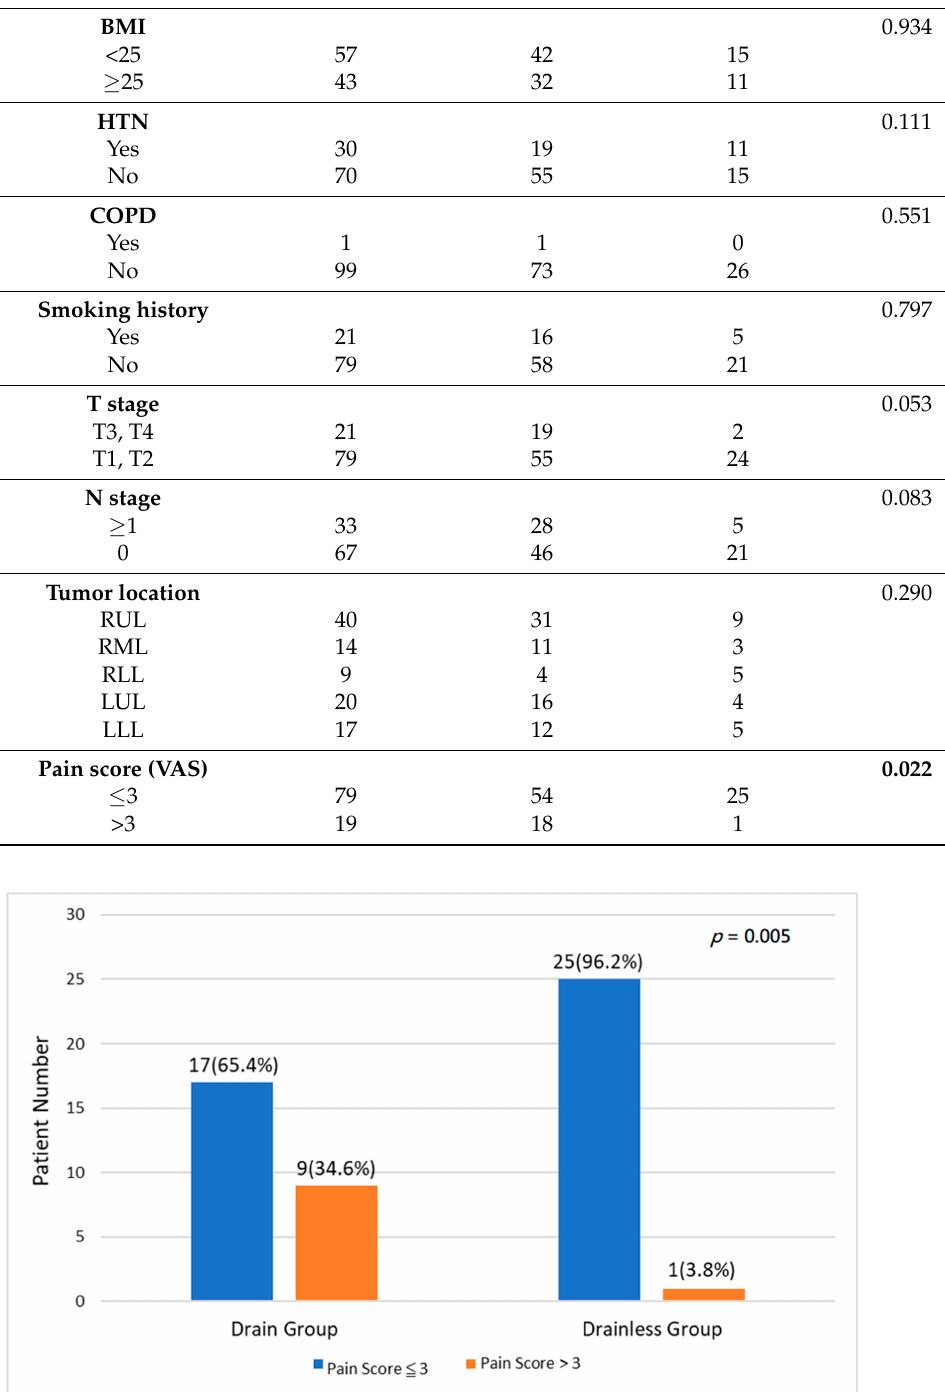
Figure 2. The comparison of pain score (<3 and >3) between the patients of minimally invasive lobectomy (VATS and RATS) with or without drainage after propensity score matching. ( p = 0.005 for statistical difference).